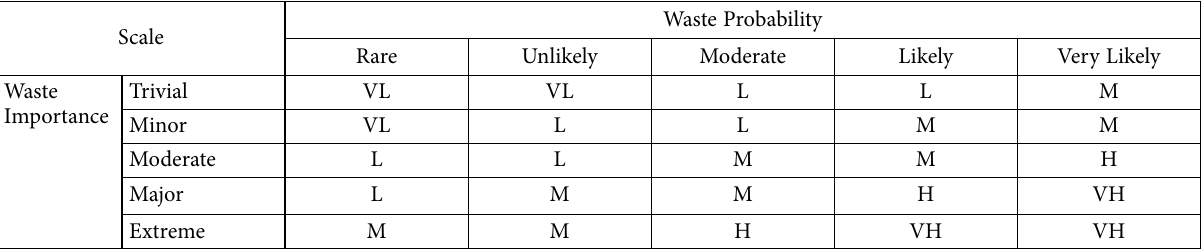
Table 2. FAMs rules for inputs and output in level 01 of LCEM